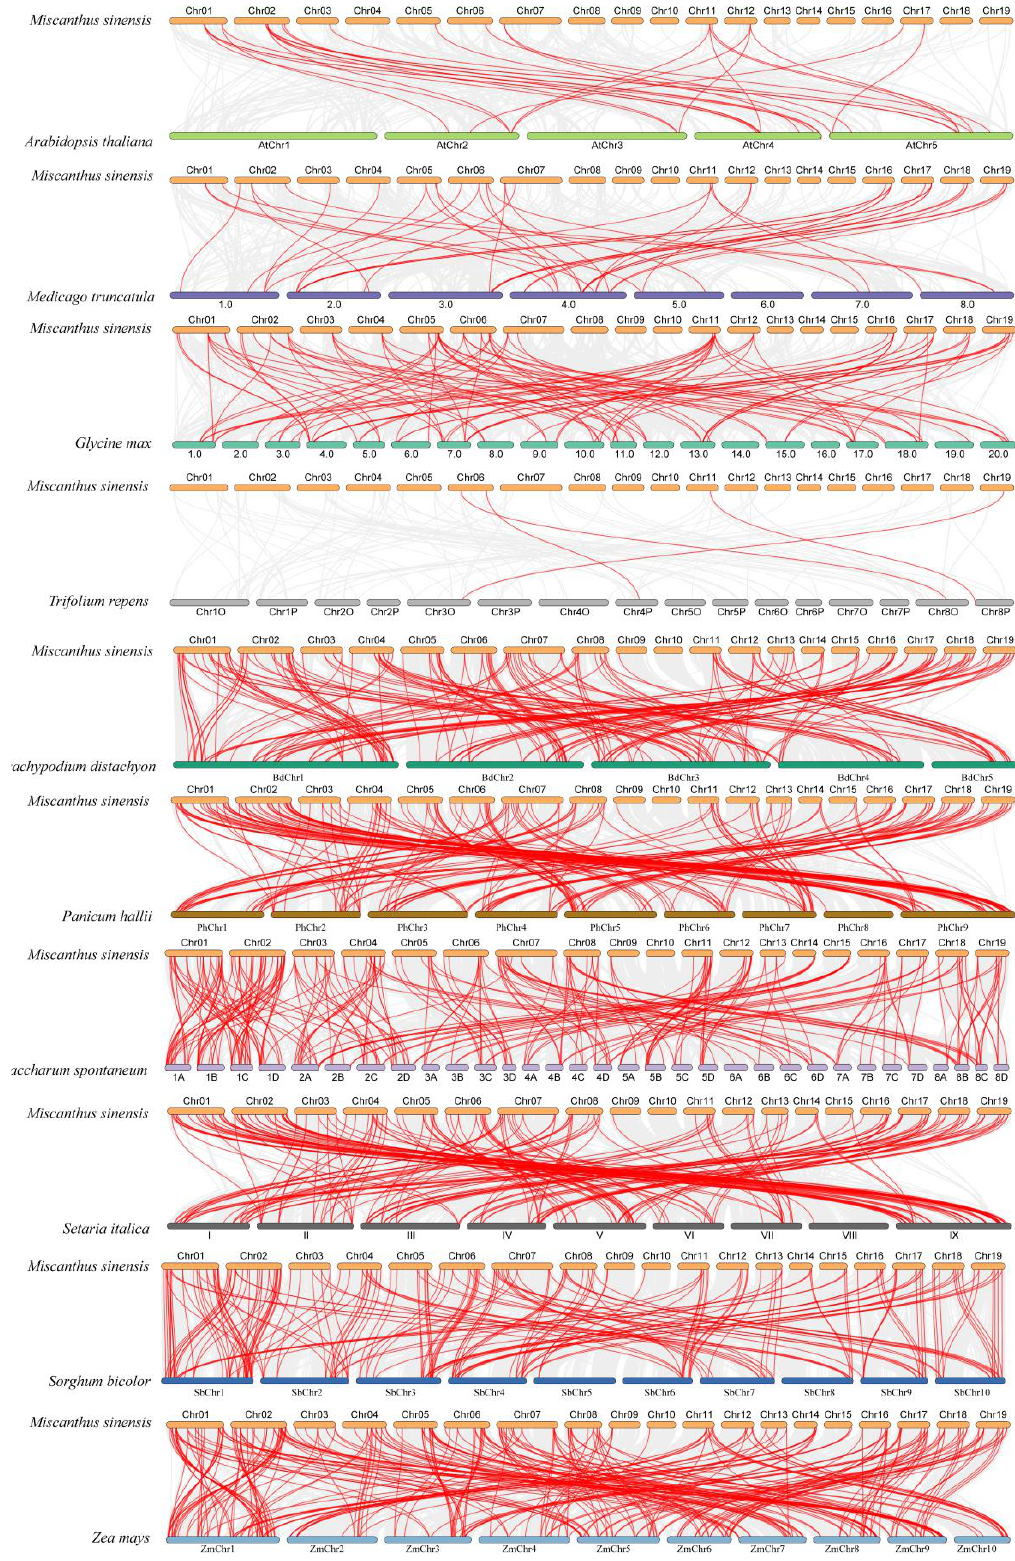
Figure 5. HD-Zip gene synteny analysis between M. sinensis and ten species. Collinear blocks from M. sinensis and other plant genomes were indicated by a gray background line, whereas syntenic HD-Zip gene pairs were indicated by a red line.